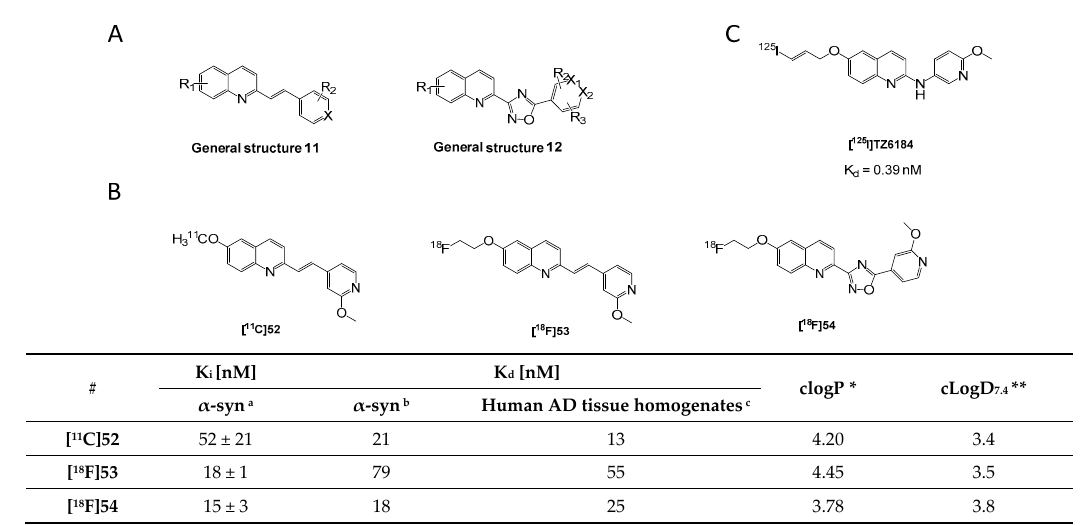
Figure 22. Chemical structures of chalcone derivatives and their affinity values expressed as K i values toward α -syn, A β and tau fibrils [133]. * clogP values were calculated by BioByte. ** clogD 7.4 values calculated by ACD/Percepta.